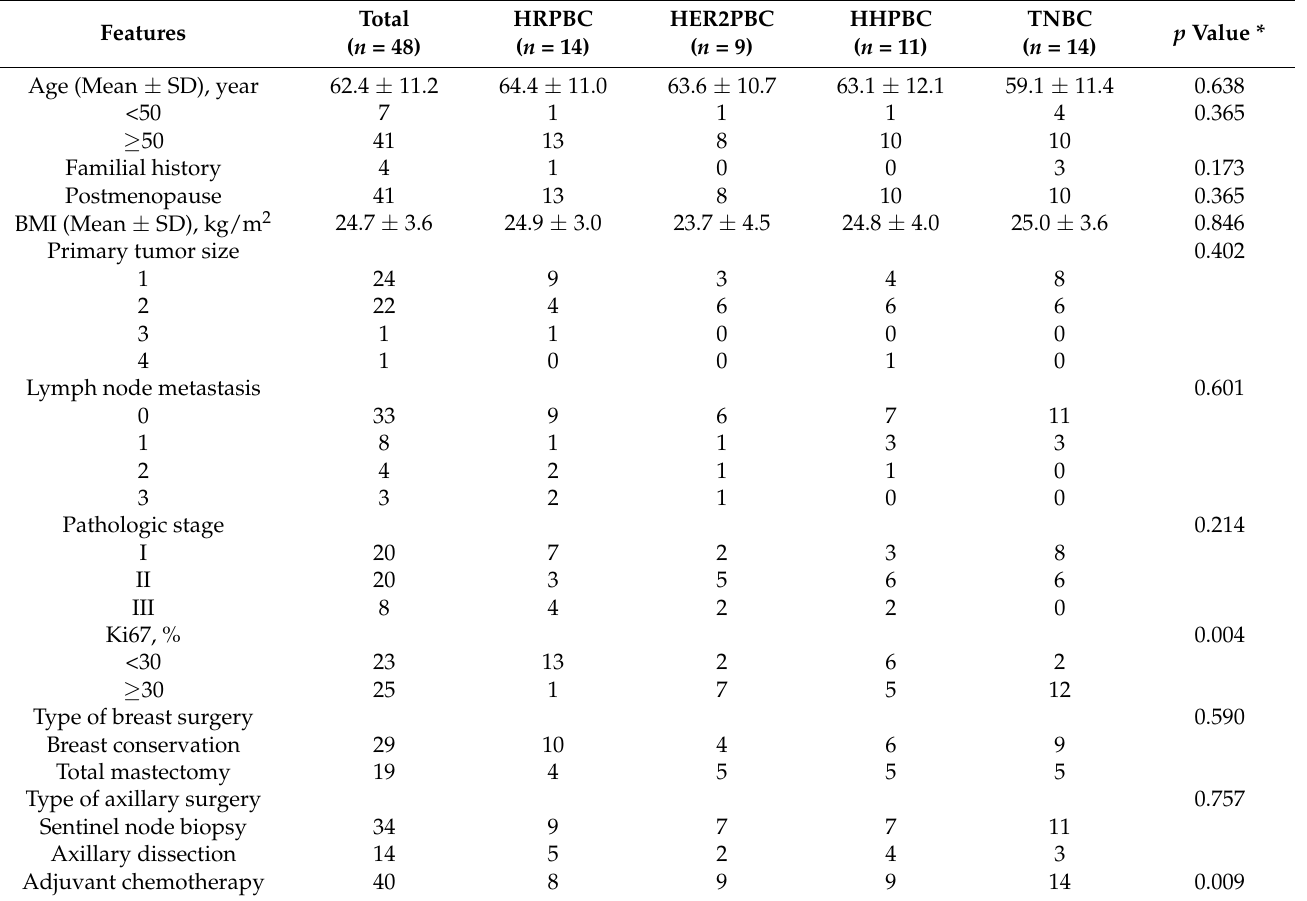
Table 1. Comparison results of clinicopathological features in 48 Korean patients with breast cancer.